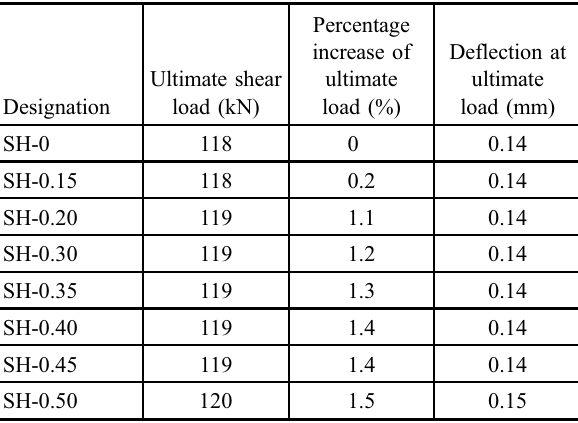
Table 5. Corbel series PH test